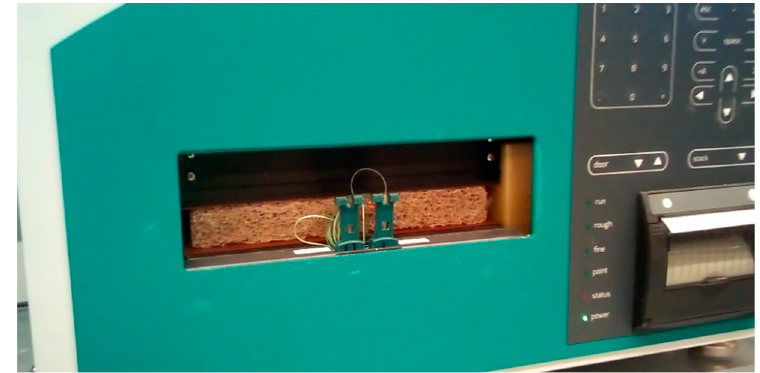
Figure 4. Netzsch HFM 446 Lambda Small device with inserted sample.